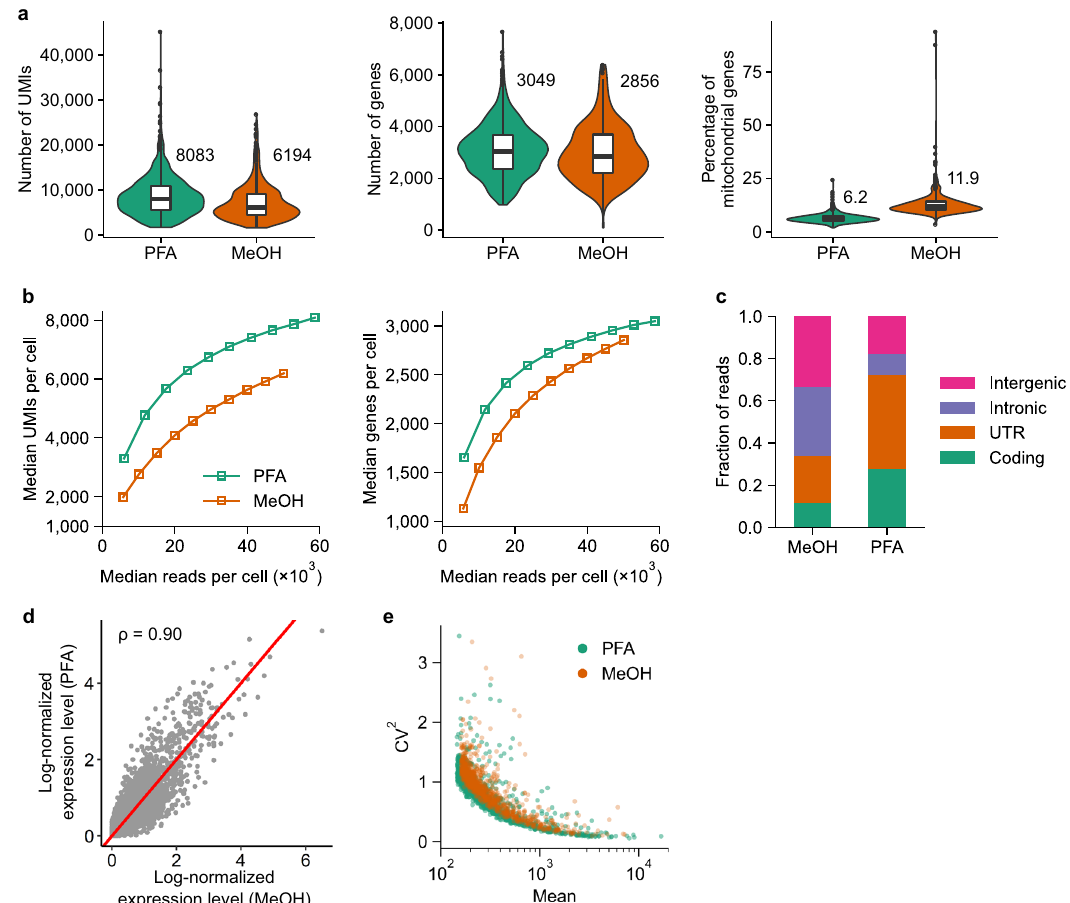
Fig. 2 Comparison between PFA and methanol fi xation shows higher gene and transcript recovery with FD-seq. a Violin and box plots of the number of UMIs, the number of genes, and the percentage of mitochondrial genes detected in single A549 cells for each fi xation method. The PFA and methanol (MeOH) samples received ~58,600 and 50,000 median reads/cell, respectively. The numbers by the violin plot indicate the median values. The middle line inside the box indicates the median, the upper and lower edges of the box indicate the fi rst and third quartiles, and the whiskers extend to 1.5× the interquartile range beyond the fi rst and third quartiles. b The effects of sequencing depth on the number of detected UMIs and genes per cell. c The distribution of mapped reads to different genomic regions. d Correlation of the log-normalized average expression level of each gene between the two fi xation methods (see “ Methods ” section). The plot also shows the Pearson ’ s correlation coef fi cient ρ between the two methods. The red line indicates y = x . e Technical variance of each gene estimated by the gene ’ s mean and squared coef fi cient of variation (CV 2 ). In a – e , n = 999 and 498 single cells for PFA and methanol samples,